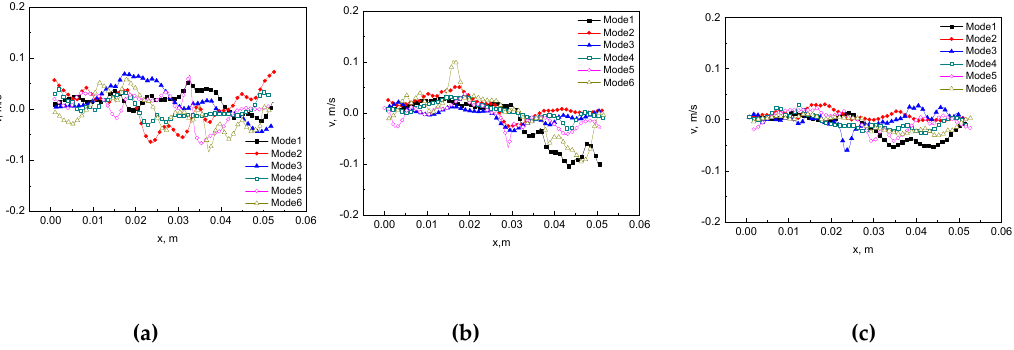
Figure 9. The horizontal component of velocity at 1 mm below the liquid surface in three physical forms of the hydraulic jump (casting speed 0.8 m/min). ( a ) CHJ. ( b ) HJT. ( c ) SLL.